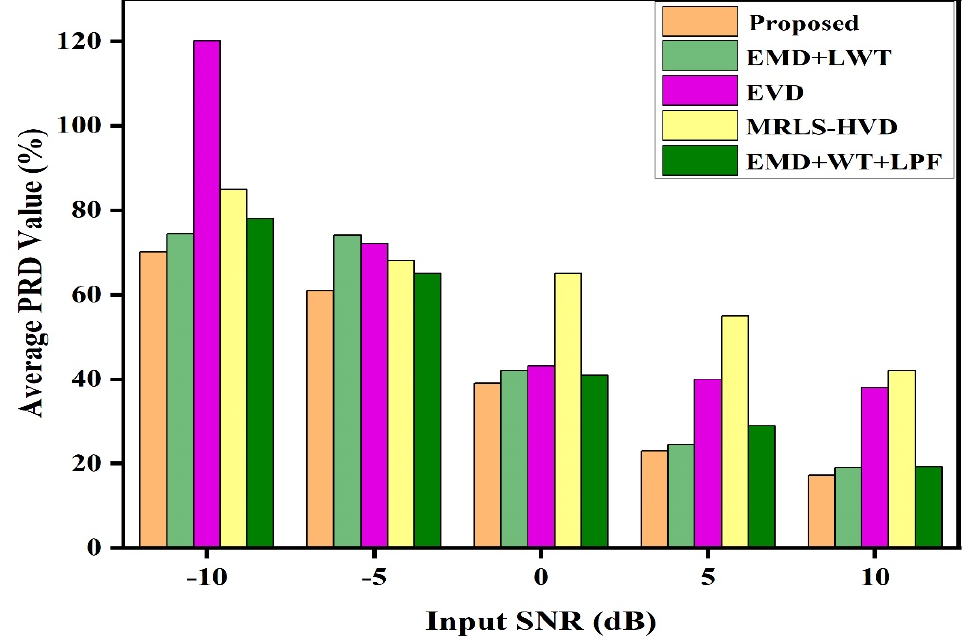
Figure 16. Comparison between the proposed method and various other methods in terms of average PRD values between the clean input and denoised output signals in presence of 60 Hz PLI and baseline wander.